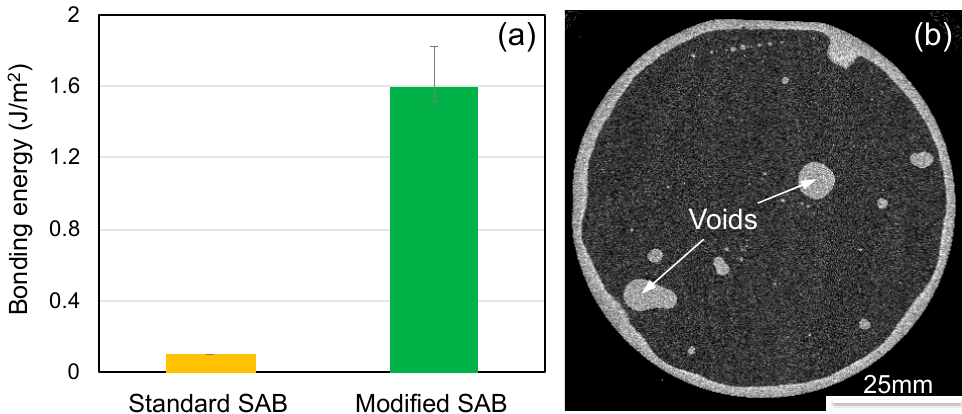
Figure 3. ( a ) Comparison of bonding energy of SiC-AlN using standard surface activated bonding (SAB) and modified SAB with Si nano-layer sputtering deposition and ( b ) scanning acoustic microscope (SAM) image of the bonded wafer of SiC-AlN.